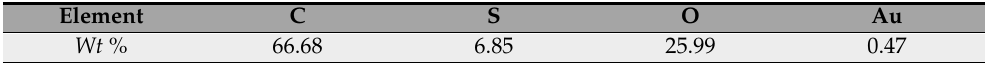
Figure 5. ( a ) EDS mapping of membranes of Au-HET with contents 5 wt%, and ( b – f ) four elements. Table 1. Mass percentage of M-PES/Au-HET-5 about different